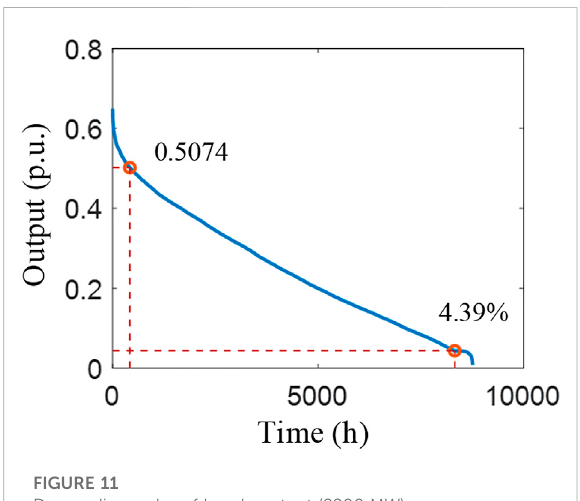
TABLE 8 AOC of wind power corresponding to key AOC (2200 MW). Available capacity percentage (%)